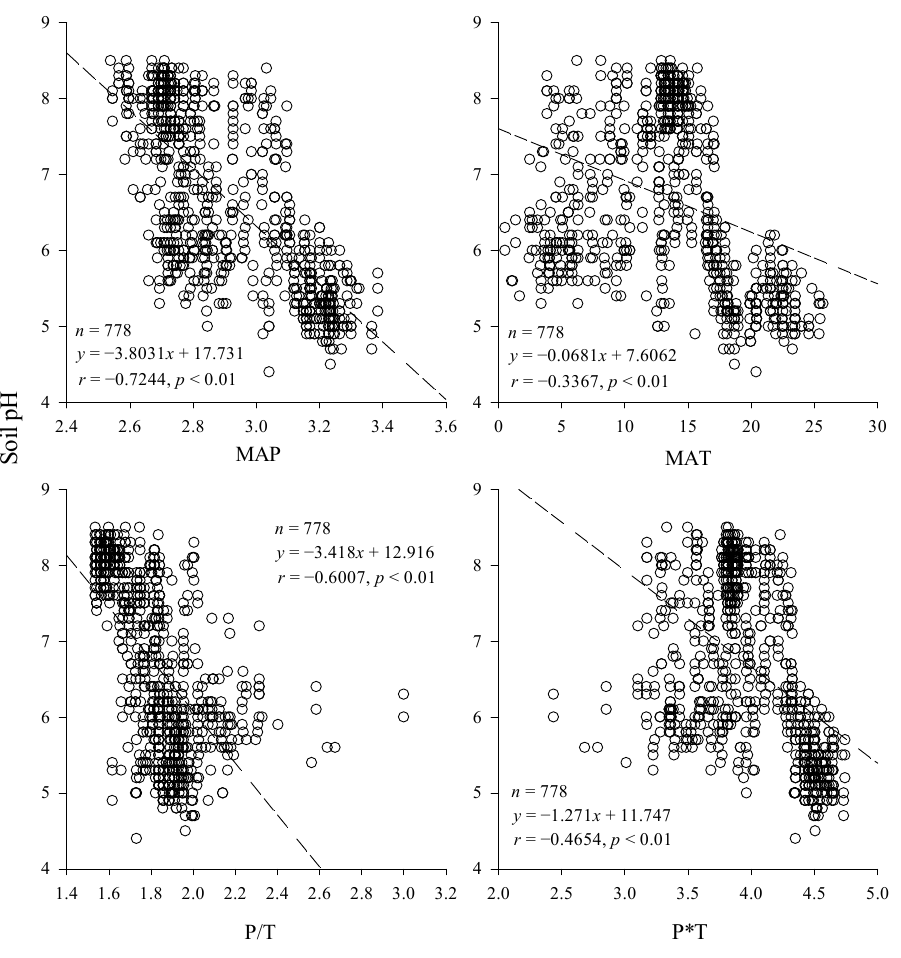
Figure 3. Relationship between soil pH and explanatory variables. Table 2. Relationships between soil pH and hydrothermal conditions in different MAP